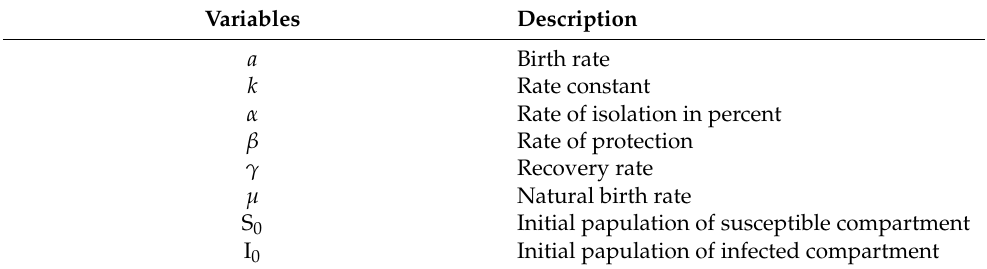
Table 1. Nomenclature involve in model (2) and their description. Variables